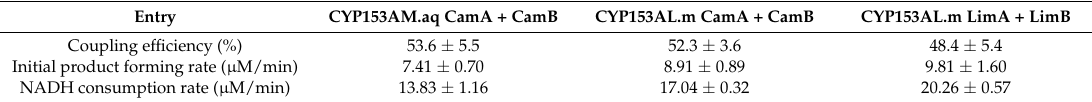
Table 1. In vitro evaluation of native redox partners of